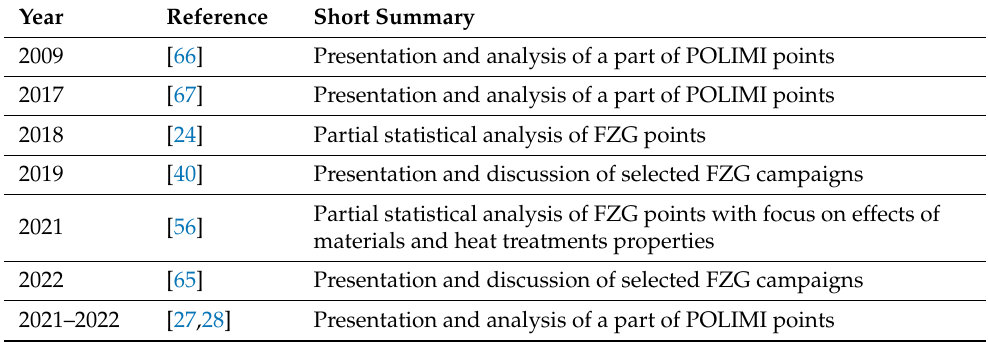
Table 1. Database reference summary.